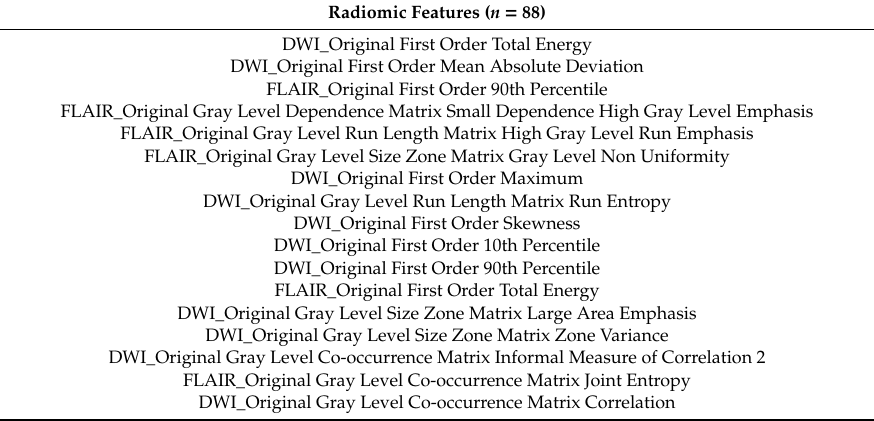
Table A3. Final Features Used by DWI-FLAIR XGBoost Model Ranked By